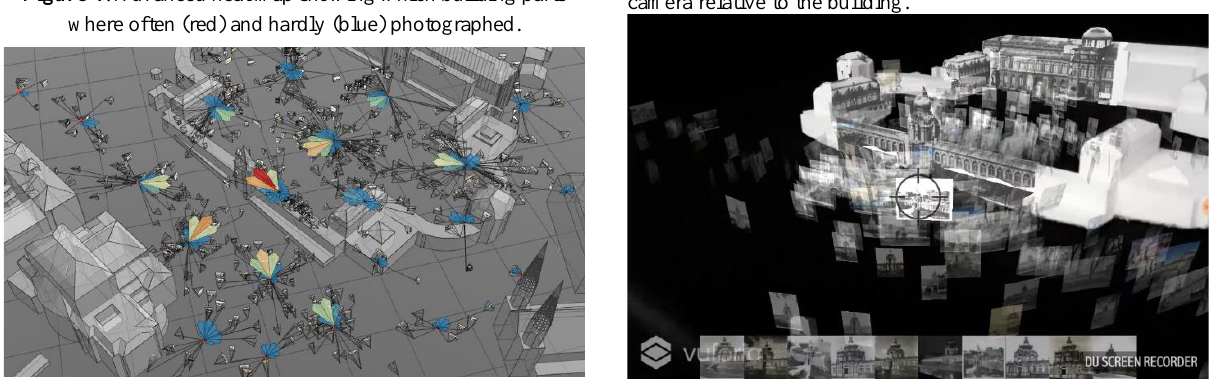
Figure 6 . Exploration of photos on 3D-printed building